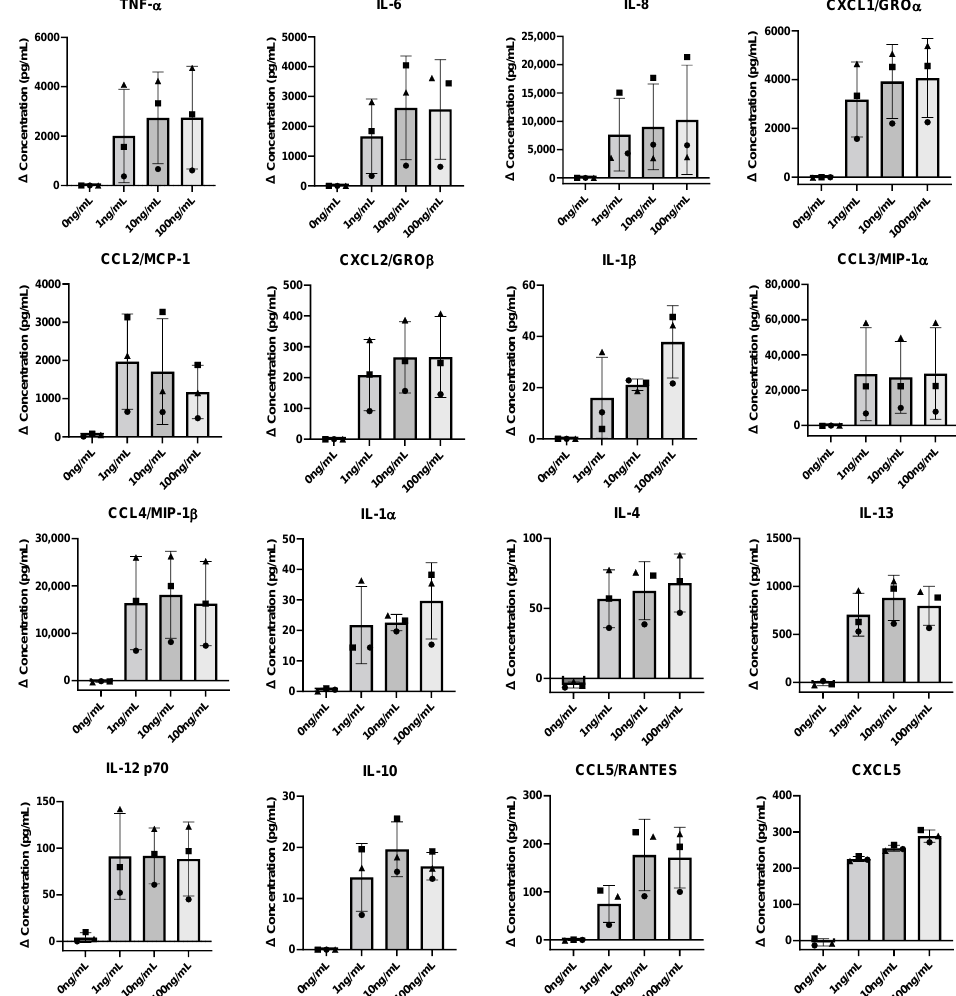
Figure 4. hiPSC-derived microglia exposed to LPS secrete elevated levels of cytokines. After 0 and 9 h of LPS (0, 1, 10, 100 ng/mL) exposure in the co-culture system, cell culture supernatant was removed and cytokine concentration quantified with a Luminex ® multiplex assay. Data displays the mean change in cytokine concentrations between 0 h and 9 h of LPS exposure. Each graphical symbol shape (square, triangle and circle) represents each set of biological replicates with at least three technical replicates. Mean values ± standard deviation of cytokine concentrations for the 0 h and 9 h timepoints are provided in Table S6.